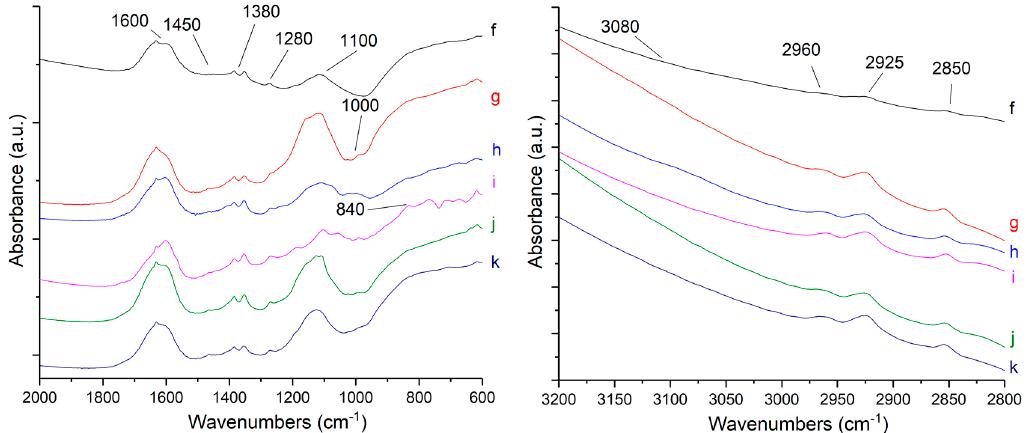
Figure 12. FT-IR spectra of CATs deactivated for different reasons ( f ) As; ( g ) Cl; ( h ) water soaked; ( i ) sintered; ( j ) caked 1; ( k ) caked 2.